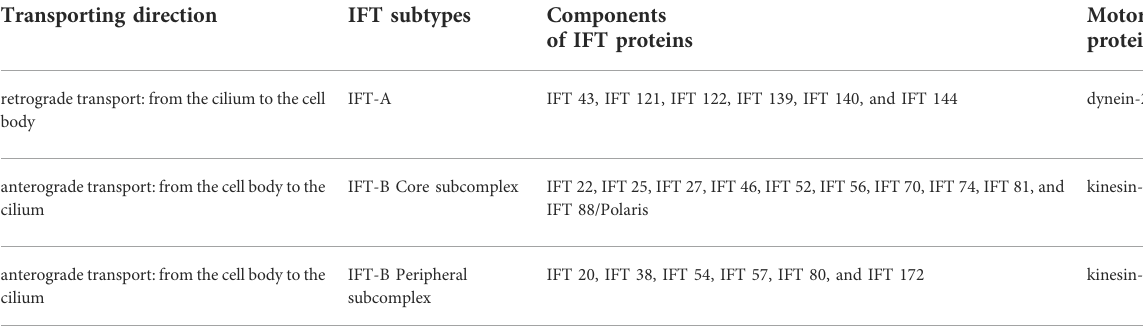
TABLE 1 The classi fi cation and function of the intra fl agellar transport (IFT)